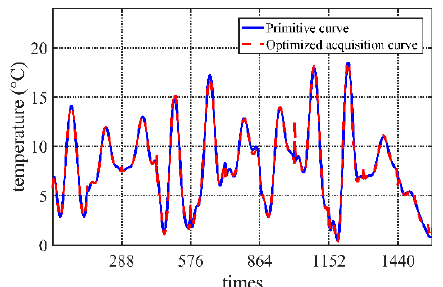
Figure 4. Comparison of optimized curve and primitive curve.